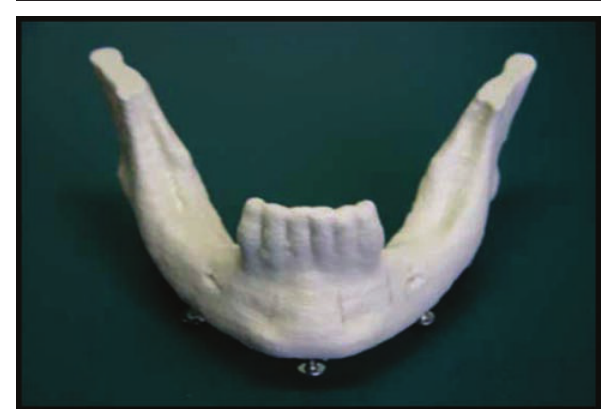
FIGURE 6 – Dentulous model produced by rapid prototyping